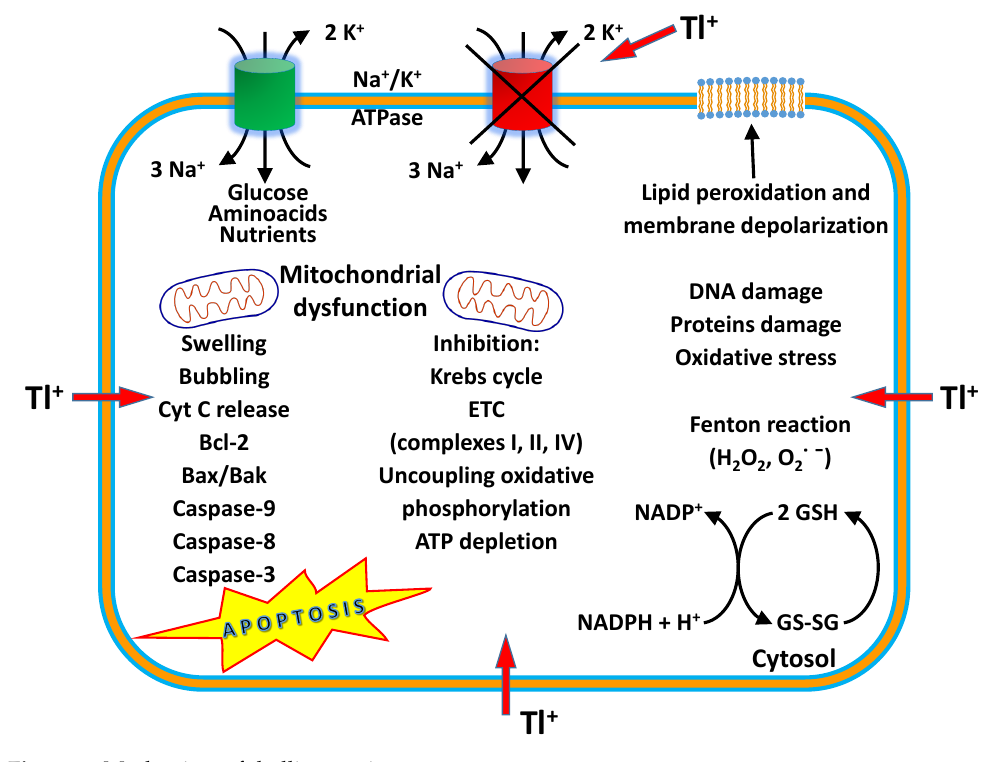
Figure 1. Mechanism of thallium